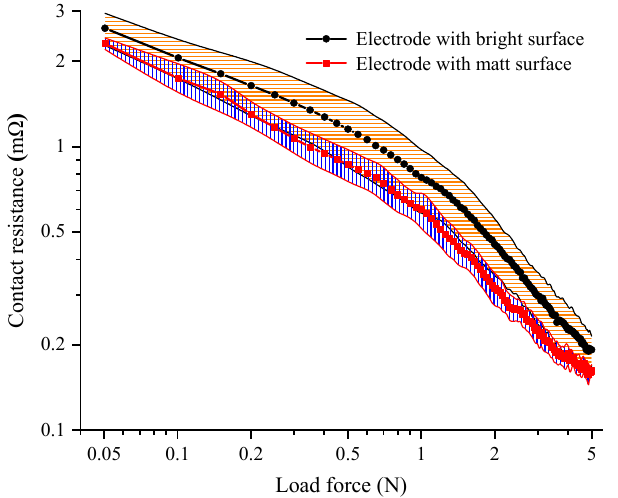
Figure 7. The variations in contact resistance as functions of the load force for AgSnO 2 (12) electrodes with bright and matt surfaces.